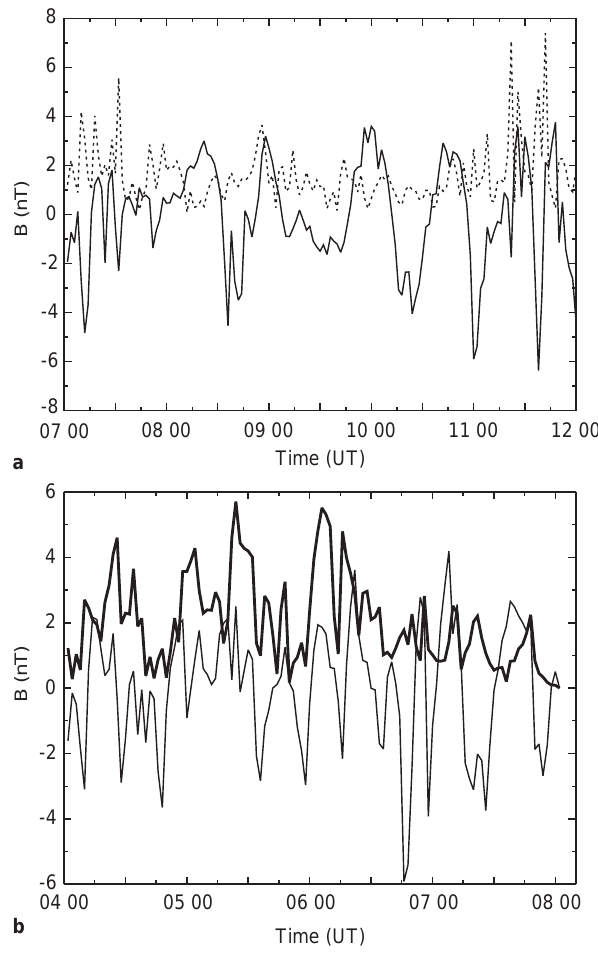
Fig. 6a, b. Magnetic field variations along and transversely to the background magnetic field for the same intervals as for Fig. 5. The solid lines correspond to compressional component and dashed lines correspond to